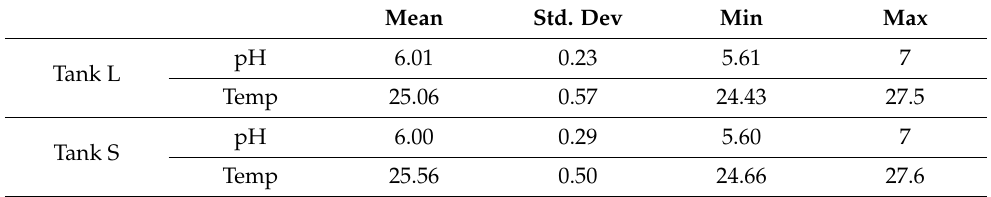
Table 5. Means of the temperature and pH for Tank L and Tank S during the 28-day experiment.